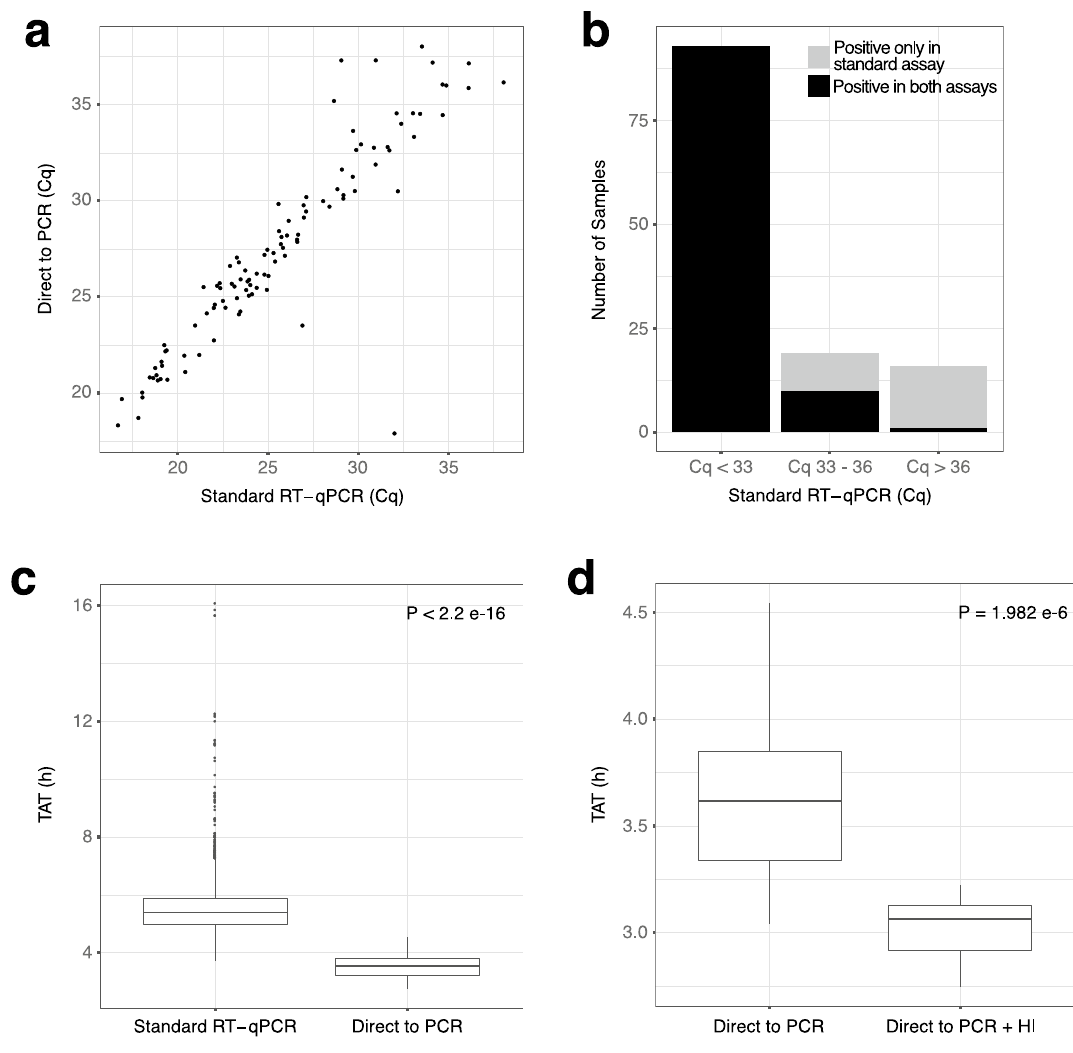
Figure 2. Direct to PCR (D2PCR) concordance data. ( a ) Cq values for samples tested as positive in both D2PCR and standard assay, showing typical increase of 2–4 Cq units with D2PCR. ( b ) Concordance of test results. Samples which tested positive in either the standard assay or the D2PCR assay binned depending on the standard assay Cq. Graph indicates the number of samples tested and the concordance by Cq bin. ( c ) Lab TAT for standard assay (including RNA extraction) compared to D2PCR. For standard test all test results generated within March 2021 are shown, for D2PCR all data from a trial run over 3 days is shown. P value calculated using Wilcox test. ( d ) Lab TAT for D2PCR, comparing Heat Inactivation during the lab process (via thermal cycler) with Heat Inactivation prior to lab entry. P value calculated using Wilcox test. Figure prepared using R